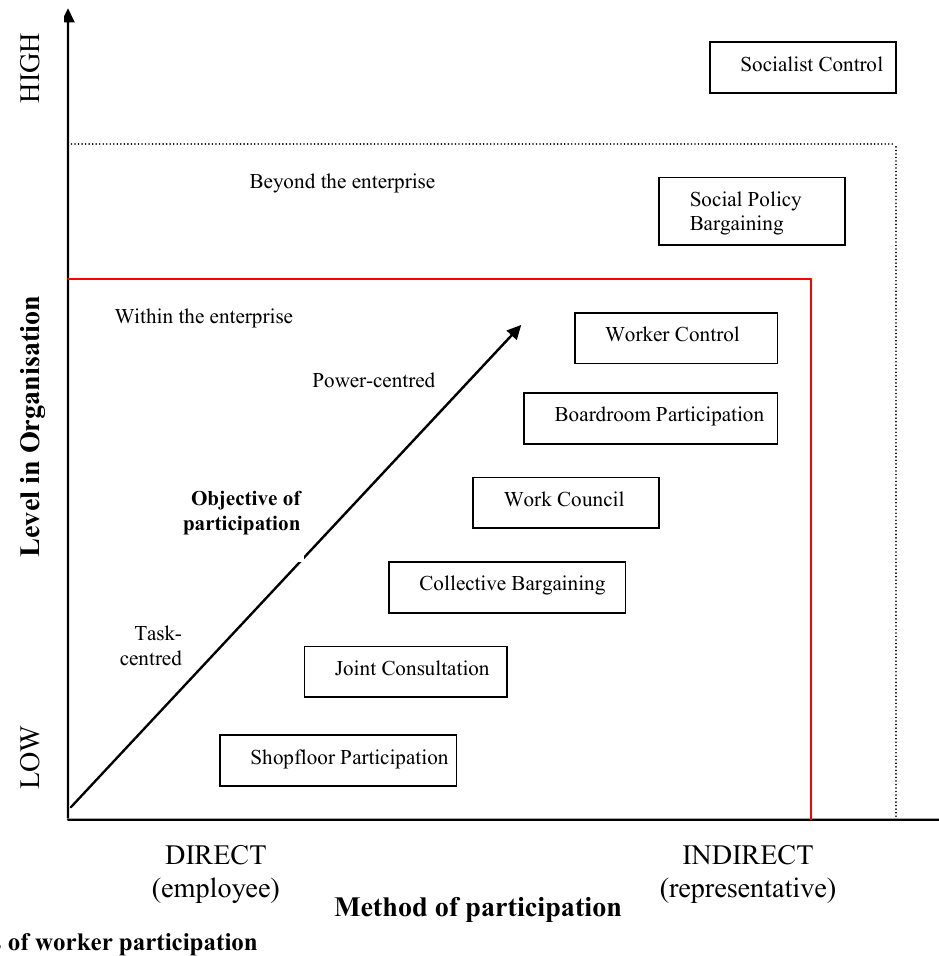
Figure 1: Levels of worker participation Source: Adapted from Salamon